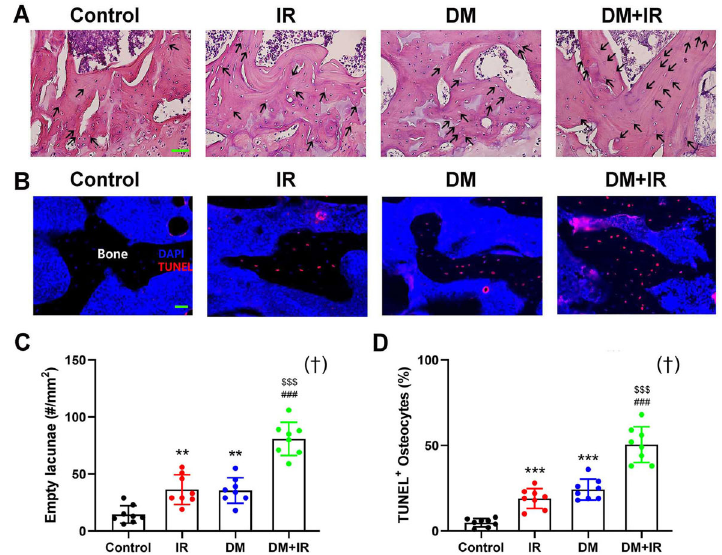
Figure 4. Effects of focal irradiation on the survival and activity of osteocytes in femoral trabeculae in streptozotocin-treated diabetic rats or non-diabetic rats. A and B , Representative H&E and TUNEL immuno fl uorescence staining images performed on decalci fi ed tibial specimens. Empty lacunae are indicated with black arrows. C and D , Quantitative analysis of empty lacunae based on the H&E staining and TUNEL-positive osteocytes per trabecular bone surface in the Control, irradiation (IR), diabetes mellitus (DM), and DM + IR rats. Scale bar 100 m m. Data are reported as means ± SD (n=8). **P o 0.01, ***P o 0.001 vs the Control group; ### P o 0.001 vs the IR group; $$$ P o 0.001 vs the DM group; w interactions between DM and IR the DM + IR group were further signi fi cantly increased compared to rats in the IR (P o 0.001) and DM (P o 0.05) groups. As shown in Figure 5H and I, gene expression pared with control rats (P o 0.01). Moreover, the gene levels of Sost and DKK1 were signi fi cantly higher in both